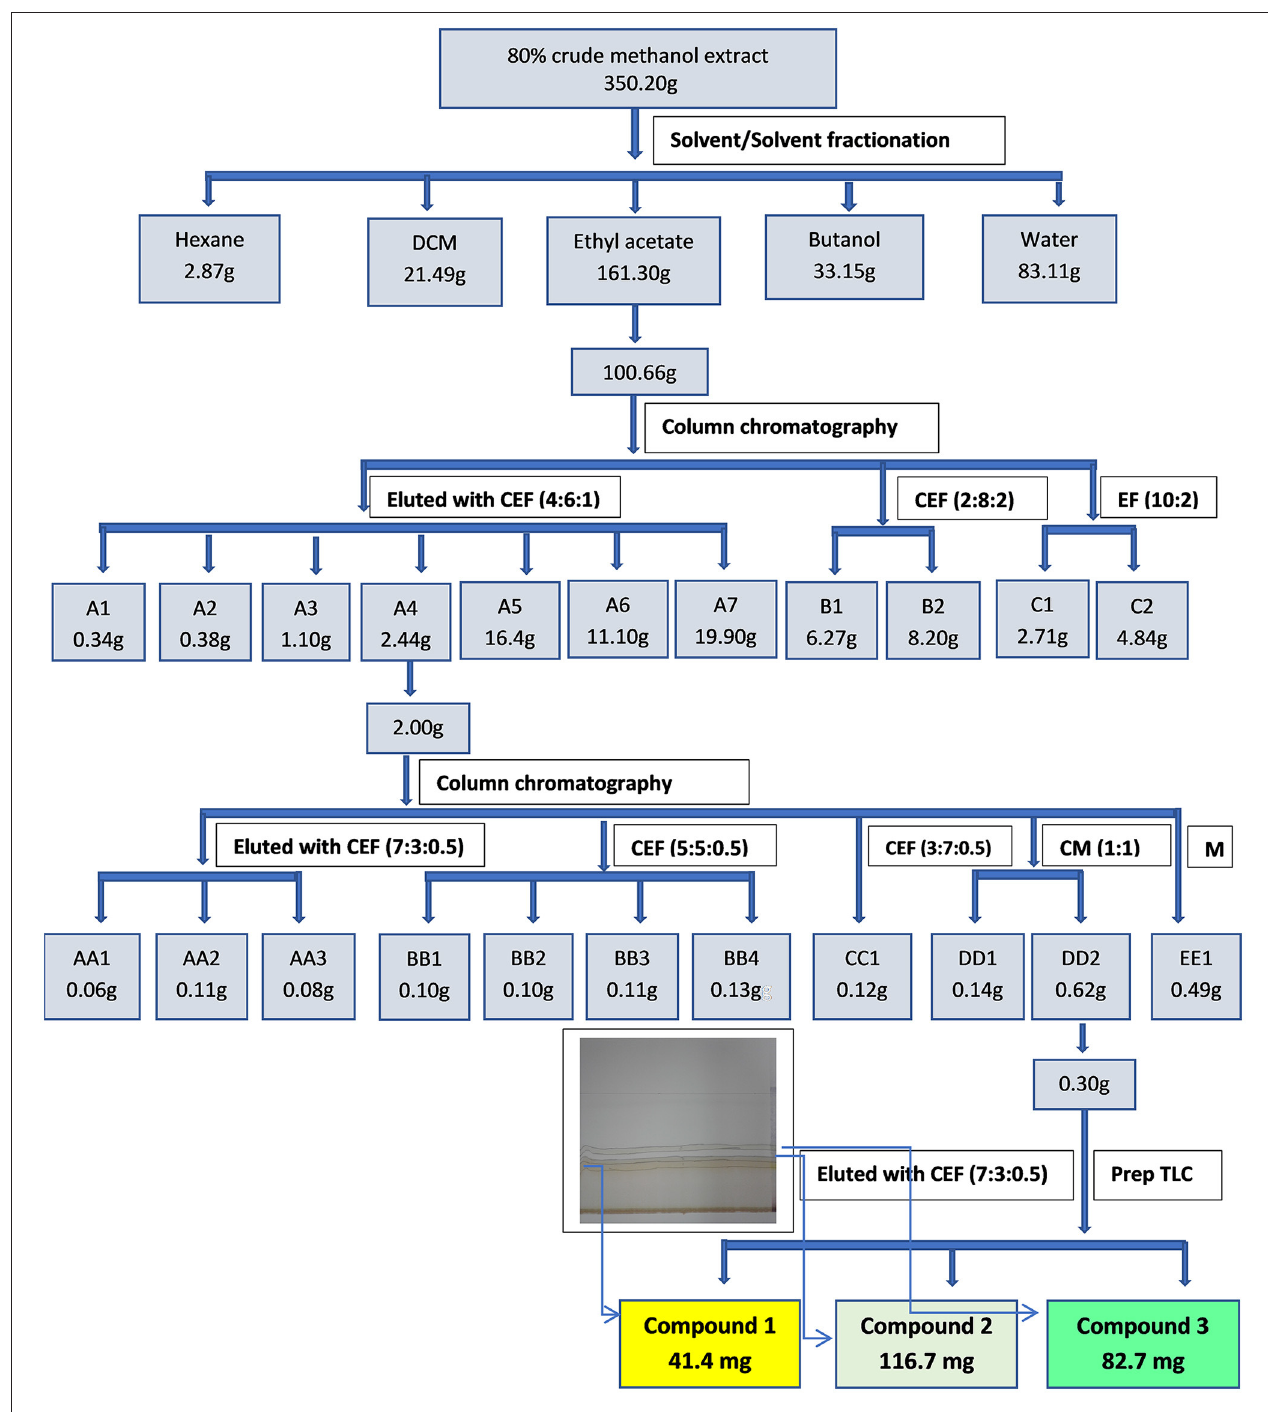
FIGURE 1 | Extraction, fractionation and isolation of bioactive compounds from the leaf extract of S. singueana.